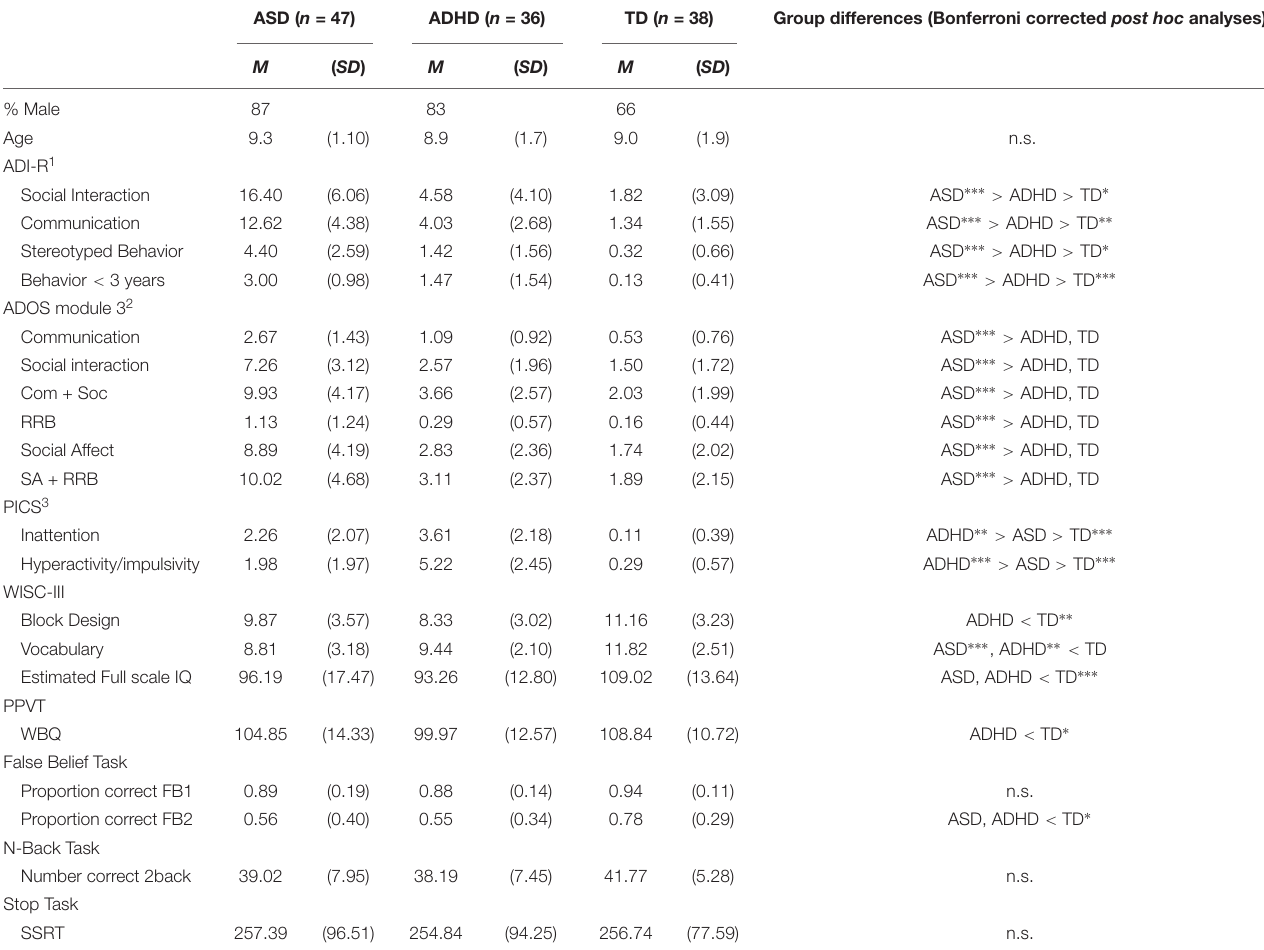
TABLE 1 | Mean scores (standard deviations) of age, clinical interviews, WISC-III, PPVT, False Belief task, n-back task, and stop